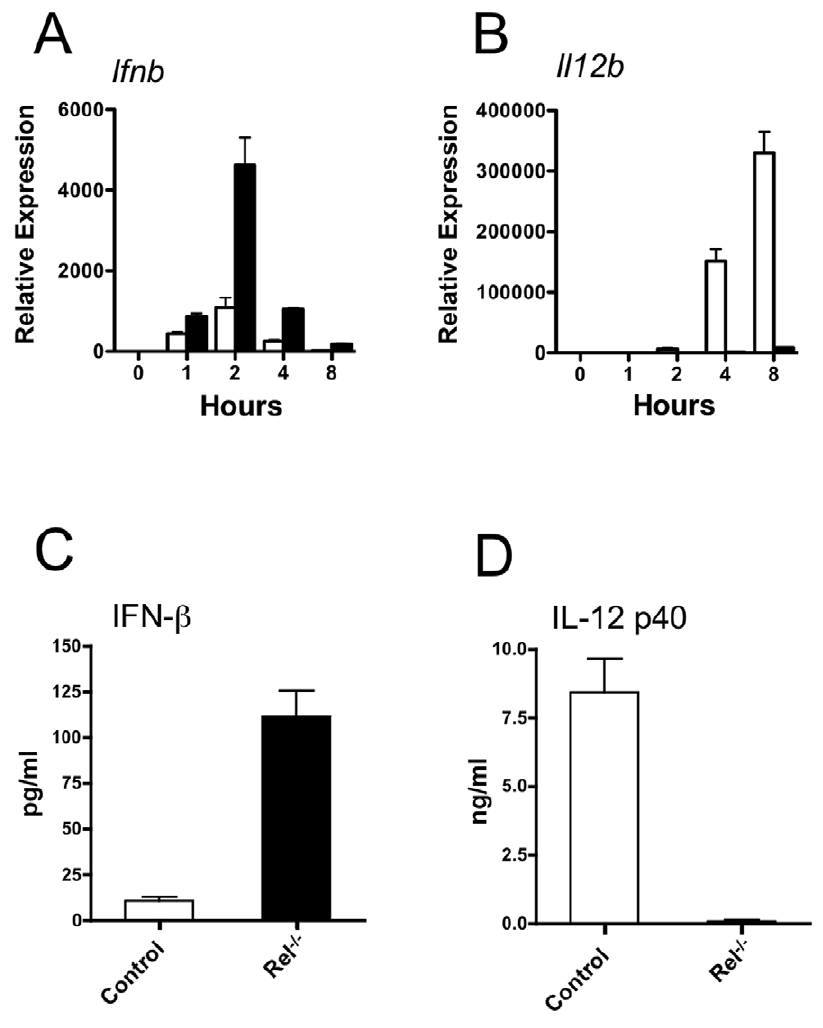
Figure 6. c-Rel inhibits LPS-induced expression of Ifnb . A) Relative expression of Ifnb and Il12b as determined by RT-PCR in Il10 2 / 2 Rag2 2 / 2 (open bars) and Rel 2 / 2 Il10 2 / 2 Rag2 2 / 2 (filled bars) BMDM at indicated time points after stimulation with LPS. N=3 mice per group. Repeated 3 times with similar results. B) Levels of IFN- b and IL-12 p40 in supernatants of Il10 2 / 2 Rag2 2 / 2 (Control) and Rel 2 / 2 Il10 2 / 2 Rag2 2 / 2 (Rel 2 / 2 ) BMDM 4 hours after stimulation with LPS. N=5 mice per group.